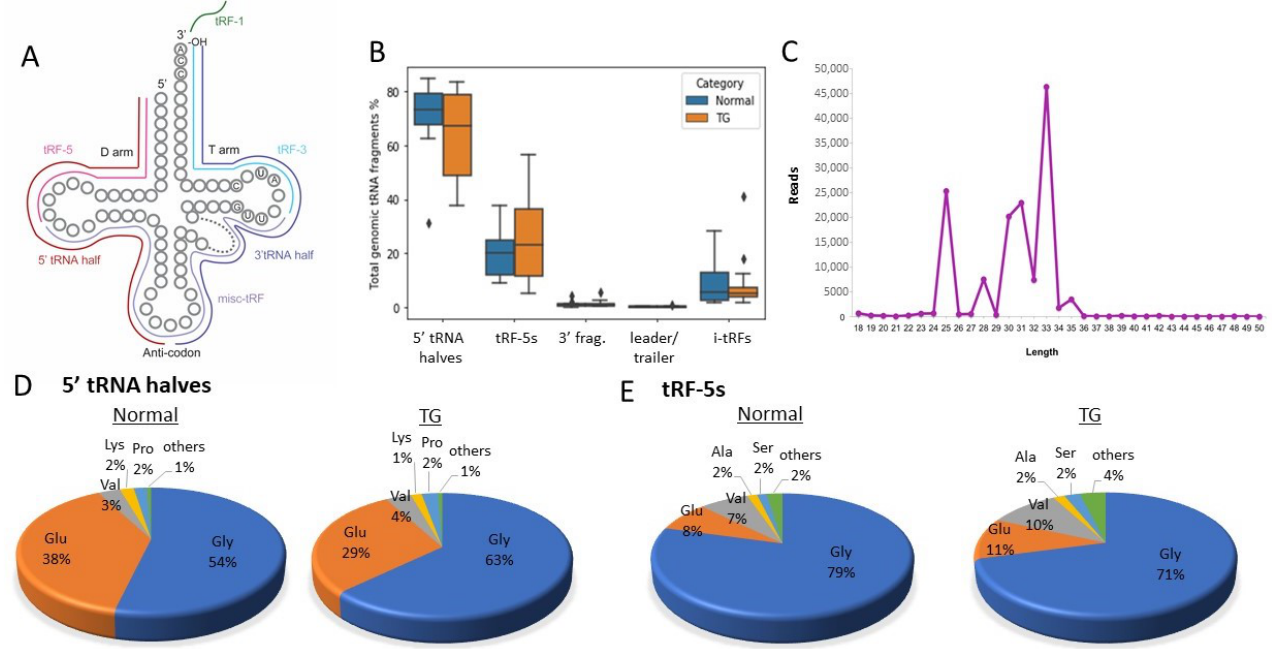
Figure 2. tRNA fragments in TG and normal allograft patients’ serum. ( A ) Schematic showing different classes of tRNA fragments. ( B ) Distribution of tRNA fragment classes in TG and control. ( C ) Length distribution of reads that mapped to 5 (cid:48) of mature tRNA-Gly-GCC (5 (cid:48) tRNA fragments) from one of the control libraries. Distinct peaks show presence of tRF-5 and 5 (cid:48) tRNA halves. ( D – E ) Pie charts showing the distribution of 5 (cid:48) tRNA halves ( D ) and tRF-5 ( E ) based on parental tRNA. Most 5 (cid:48) tRNA halves and tRF-5s are produced from tRNA-Gly and tRNA-Glu both in TG and